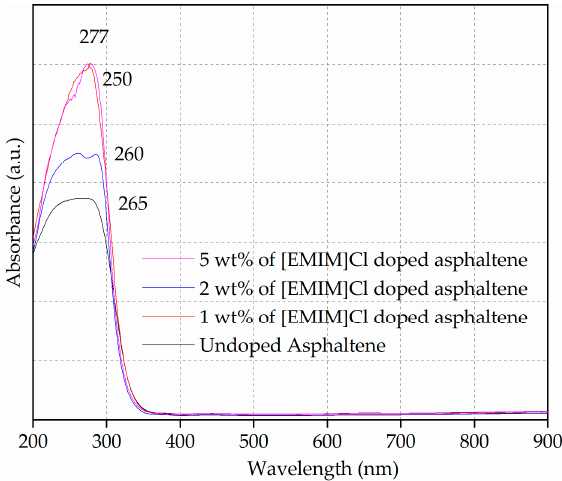
Figure 5. UV-Vis spectra of undoped and [EMIM]Cl-doped asphaltene thin film on glass substrate.